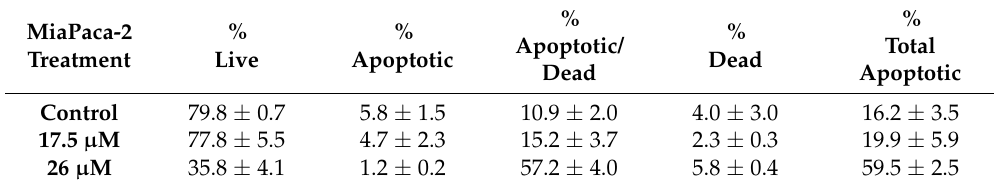
Figure 4. Caspase 3/7 analysis to assess apoptosis of MiaPaca-2 cells after 24h treatment with BisP4: ( A ) 0 µM (no compound); ( B ) 17.5 µM; and ( C ) 26 µM. The lower left quadrant depicts live cells not undergoing detectable apoptosis; the lower right quadrant shows cells in the early stages of apoptosis; the upper right quadrant shows cells in the late stage of apoptosis or dead by apoptotic mechanisms; and the upper left quadrant shows cells that died via necrosis but not through the apoptotic pathway. Table 2. Mean percentage (%) of gated events ( n = 3, ± SD), corresponding to cells that are viable (% Live), in the early stages (% Apoptotic) and late stages of apoptosis (% Apoptotic/Dead), and dead (% Dead), following 24 h BisP4 treatment and control.